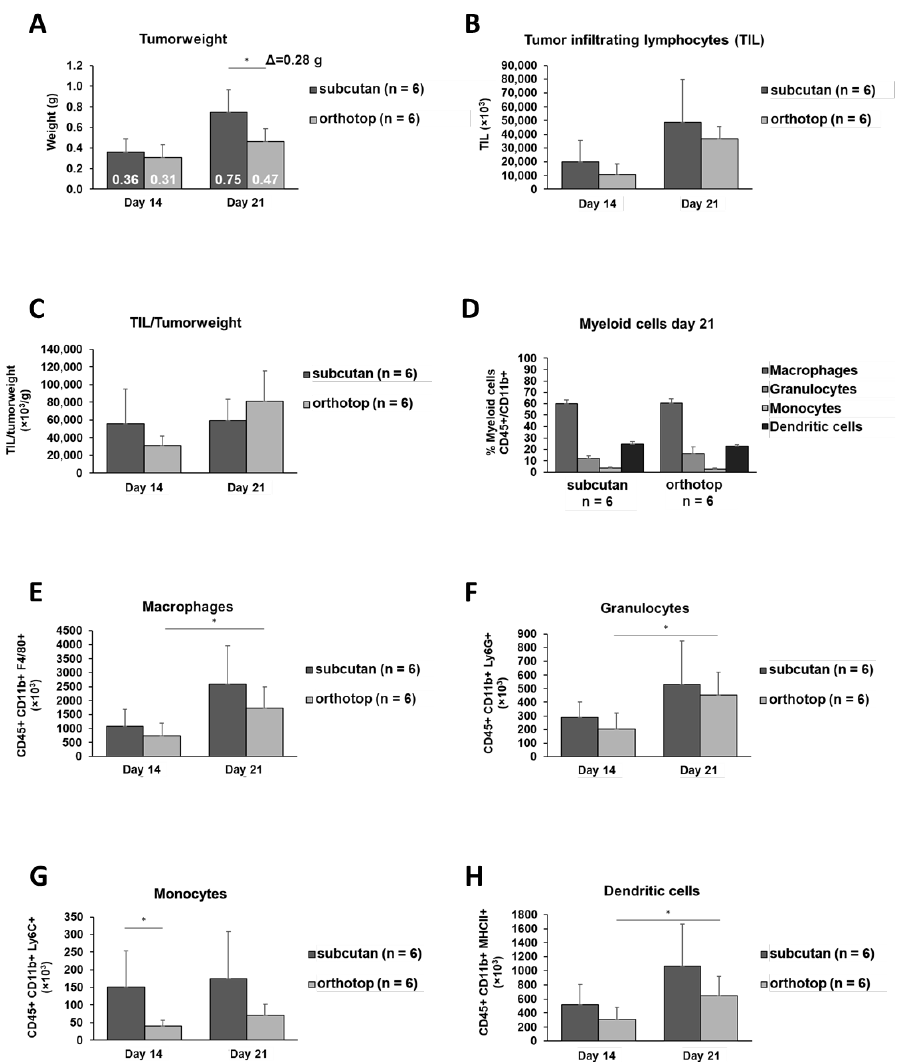
Figure 2. The tumor growth, the absolute number of tumor-infiltrating lymphocytes (TIL), the TIL/tumor weight, and the total number of myeloid cells of orthotopic and subcutaneous head and neck squamous cell carcinoma (HNSCC) bearing mice. Tumors were harvested 14 days and 21 days after tumor induction, and the tumor weight, including the difference in the average tumor weight of both experimental groups ( ∆ = 0.28g) ( A ), the absolute numbers of TIL ( B ), the numbers of TIL per g tumor ( C ), the relative TIL myeloid cell distribution ( D ), and the absolute numbers of macrophages, granulocytes, monocytes, and dendritic cells ( E – H ) were determined. On day 14 and day 21, the test group size for the subcutaneous group was n = 6, and for the orthotopic group n = 6. p -values < 0.05 were considered to be significant with (*). Data shown here are listed in Table S1.